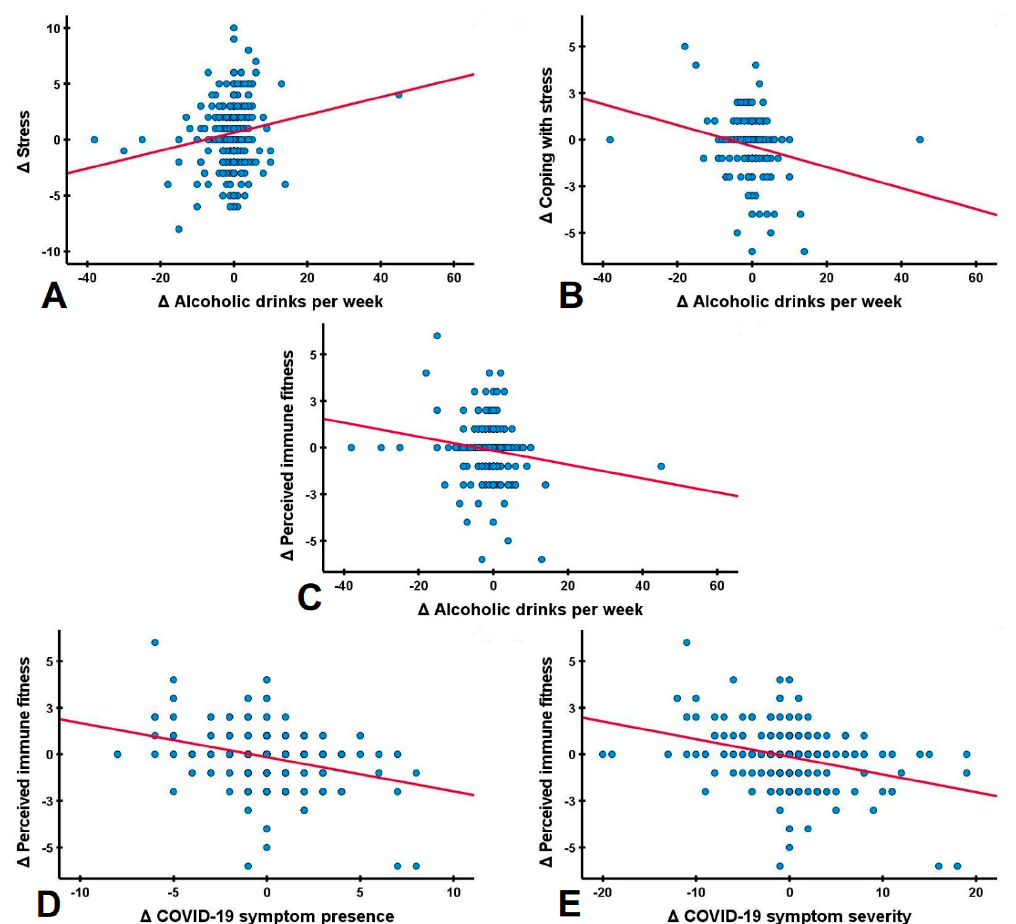
Figure 2. Correlations between changes in stress, alcohol consumption, perceived immune fitness and the presence and severity of COVID-19 symptoms during the COVID-19 lockdown. Pearson correlations (red lines) of difference scores ( Δ , during COVID-19 lockdown versus before COVID-19 lockdown) are shown for ( A ) stress and alcoholic drinks per week; ( B ) coping with stress and alcoholic drinks per week; ( C ) alcoholic drinks per week and perceived immune fitness; ( D ) perceived immune fitness and the presence of COVID-19 symptoms and ( E ) perceived immune fitness and the severity of COVID-19 symptoms. All correlations were statistically significant ( p < 0.01).